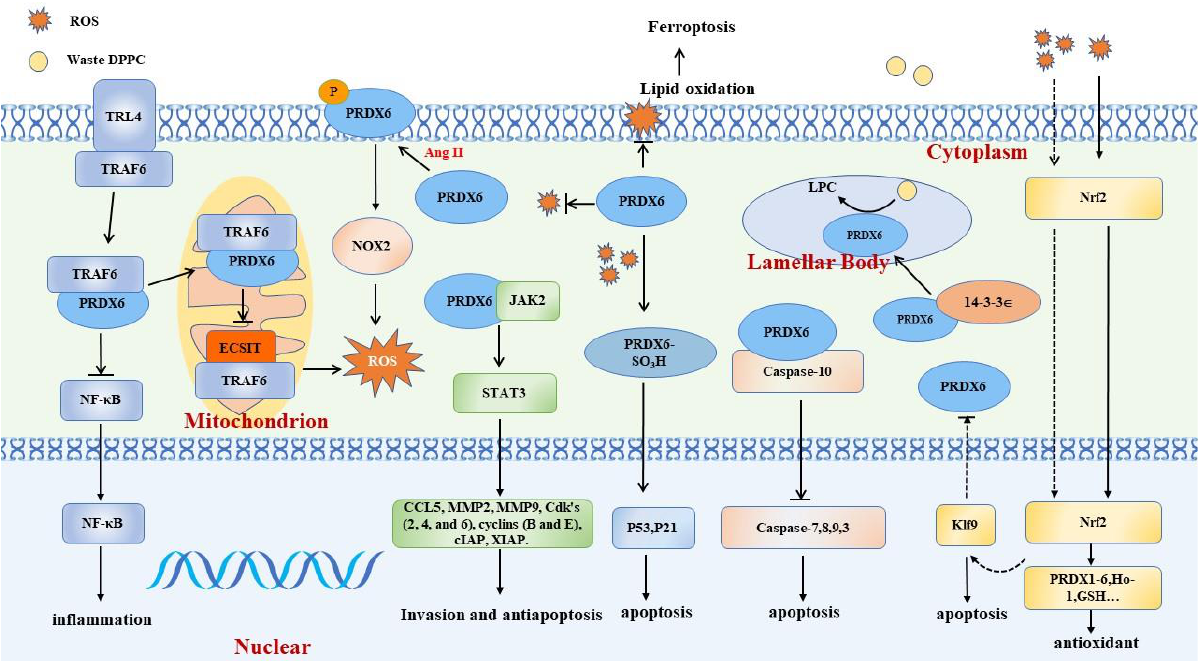
Figure 2. Functions of PRDX6. PRDX6 plays a complex role, with some of the processes in which it is involved including anti-oxidation; pro-oxidation; phospholipid metabolism; and cell proliferation, invasion, and apoptosis regulation. The functions of PRDX6 may be regulated by oxidative stress intensity, cytokines, and other factors.